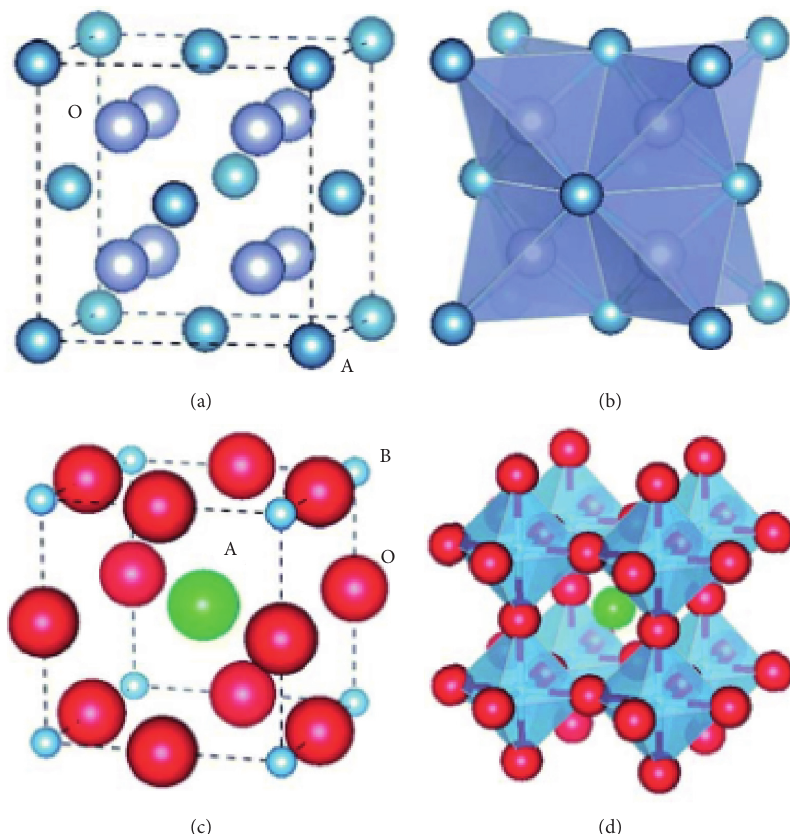
Figure 4: Packing and structural arrangement of (a, b) fluorite structure (AO green atoms: A, blue atoms: B, red atoms: O